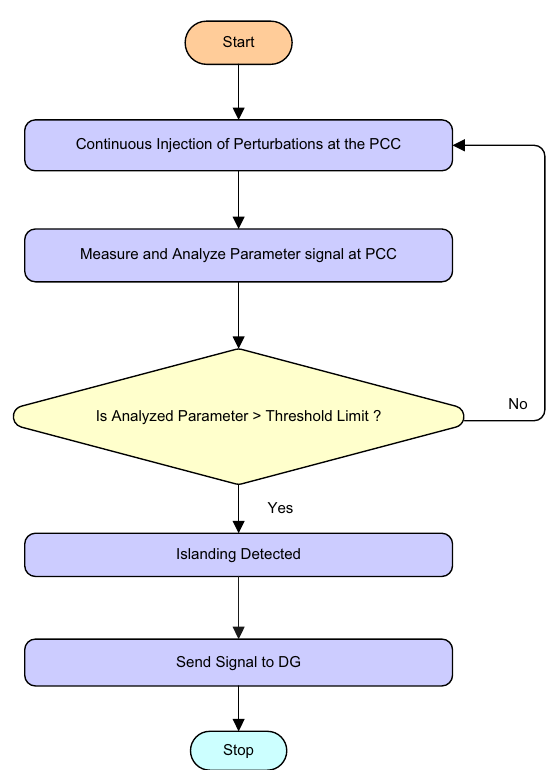
Fig. 5 Algorithm for active islanding detection